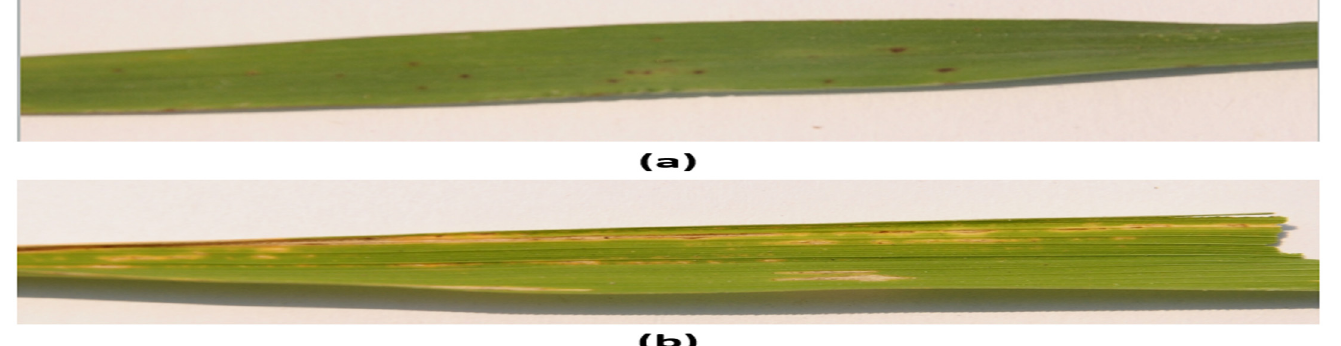
Figure 2. Class Samples: ( a ) leaf smut; ( b ) bacterial blight.